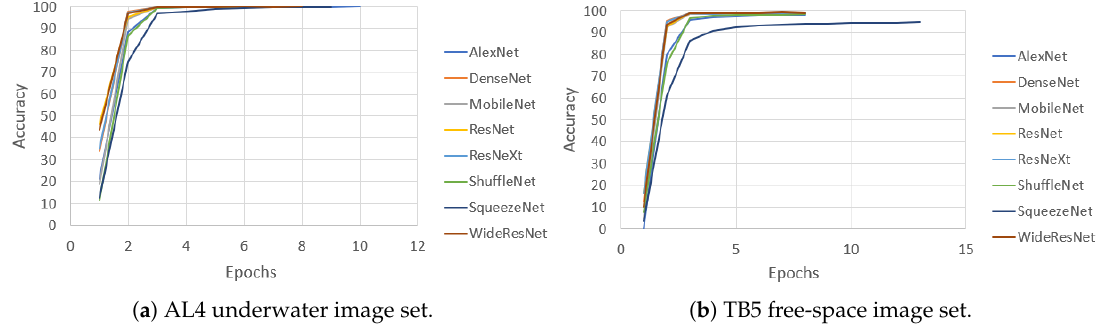
Figure 10. Accuracy training curves for AL4 underwater and TB5 free-space OAM